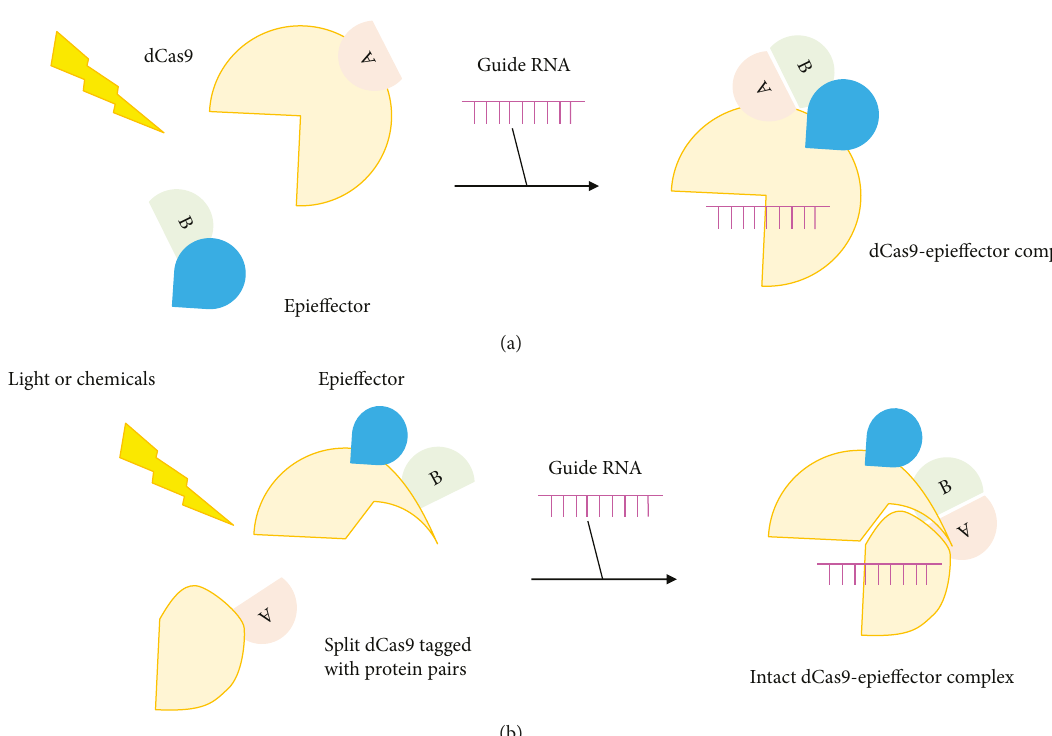
Figure 3: Schematic of temporal and spatial control of epigenome editing. The semicircles labeled with (A) and (B) represent a protein pair. The magenta comb-like lines represent guide RNA sequences. (A) is bound to dCas9, which would be directed by the guide RNA to the DNA target. (B) is bound to the epie ff ector. (a) Upon stimulation of light or chemicals, (A and B) would pair with each other thus bringing the dCas9 and epie ff ector together to achieve site-speci fi c epigenome editing at a given time point. (b) Another strategy is splitting the dCas9 into two parts, each of which is bound by protein (A) or (B). Upon light or chemical stimulation, (A) and (B) would gather together to reconstruct an intact dCas9-epie ff ector complex to achieve site-speci fi c epigenome editing at a given time